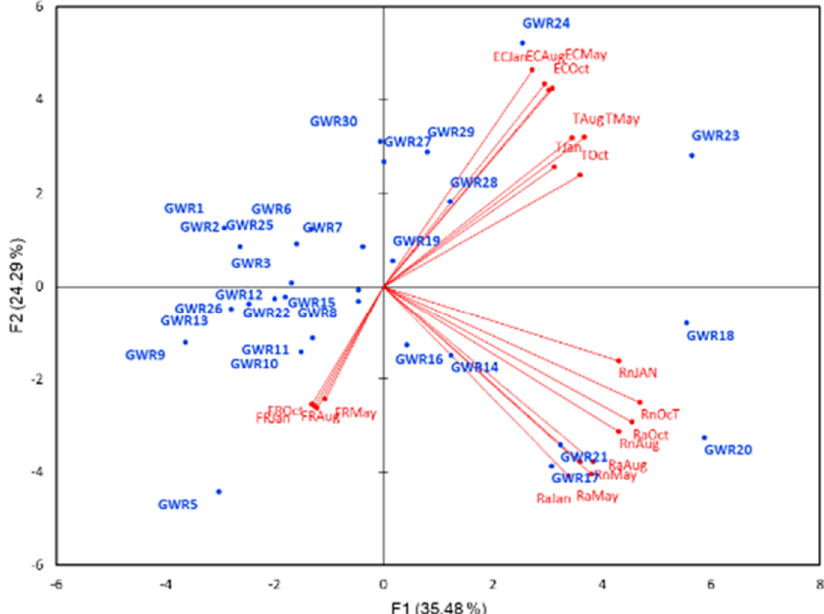
Figure 2. The PCA of temperature (T), electrical conductivity (EC), flow rate (FR), radon (Rn), and radium (Ra) in the analyzed karstic springs (GWR—GWR30, except GWR4) for four months (Oct =